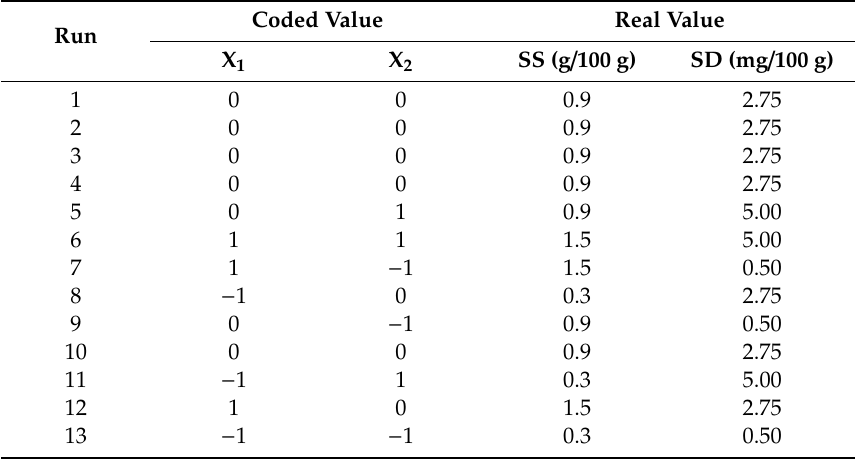
Table 1. Coded and real values of formulation factors used in the experimental design.